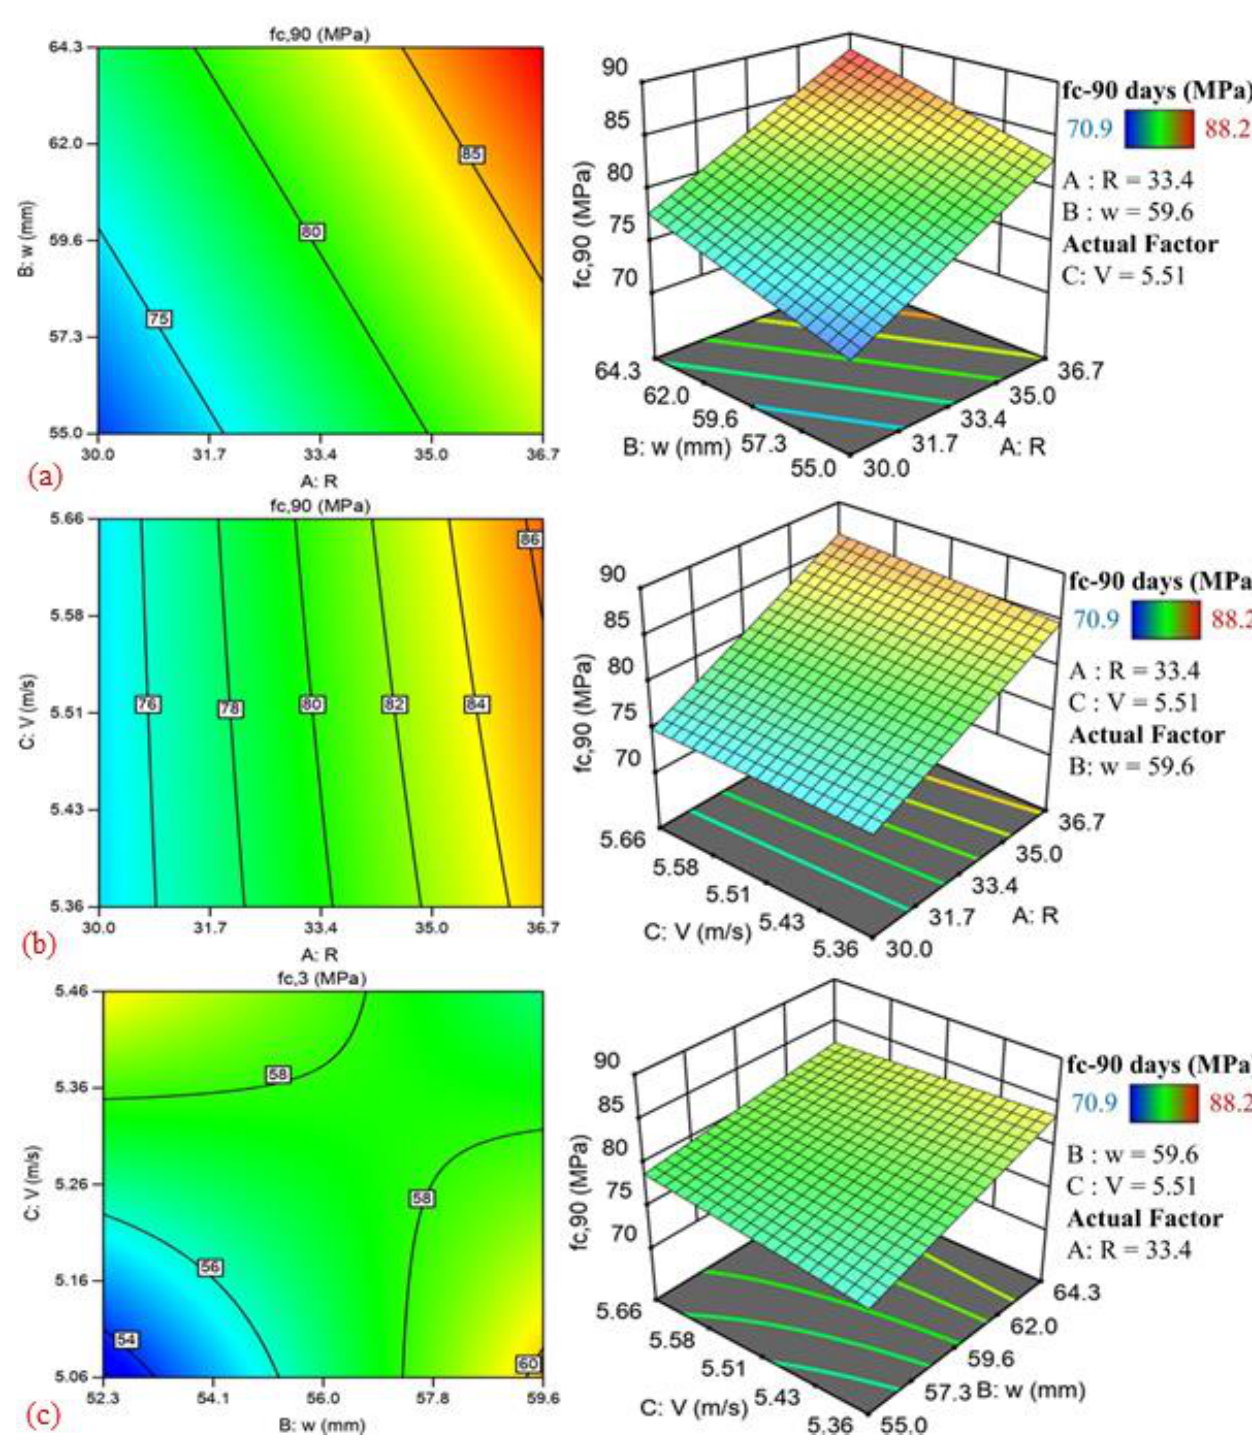
Figure 8. The effect of model 4 on final-age strength: ( a ) Model 1, ( b ) Model 2, and ( c ) Model 3.